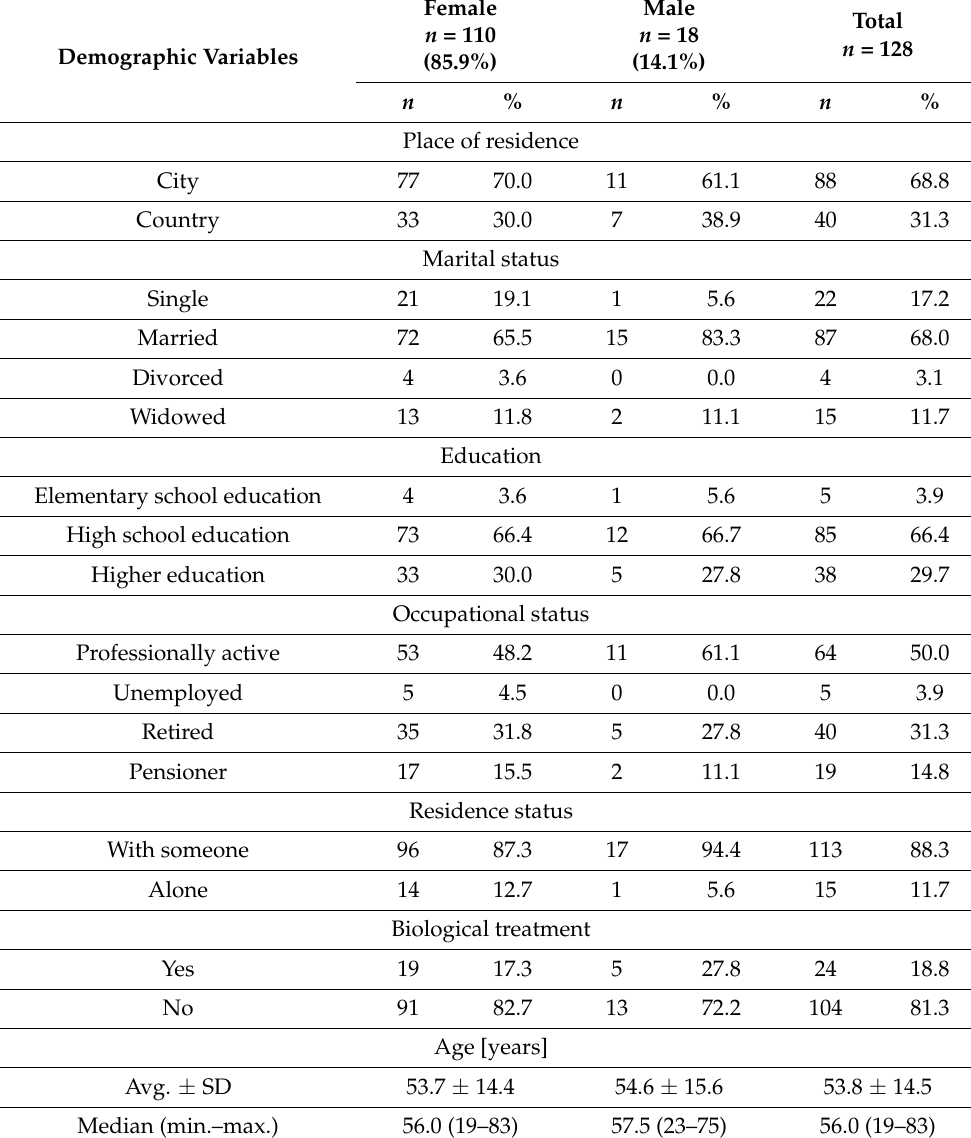
Table 1. General characteristics of the respondents for demographic